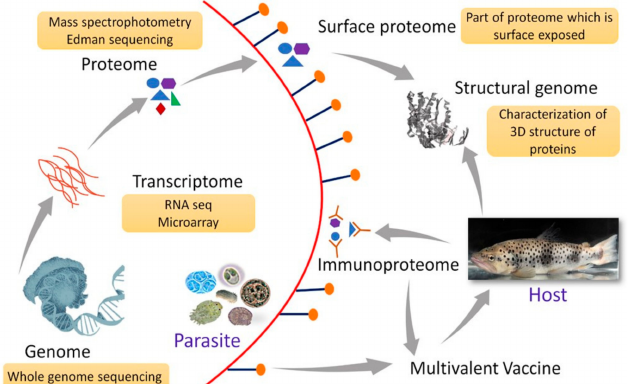
Figure 1. Conceptual representation of multivalent/multiepitope vaccine formulation for fish para- sites in the omics era. Analysis of genomic, transcriptomic and proteomic data of parasite and the data obtained from host–parasite interactions enable identifying a suitable antigen as vaccine candidates. Genome sequence contains the entire genetic repertoire of antigens from which novel vaccine targets can be selected. Transcriptome analysis provides insights on the parasite gene expression profile leading to successful establishment and pathology in host. Proteomic analysis provides information on protein expression under specified conditions. It is useful in identification of proteins that are ex- pressed by parasite during infection and the subset of proteins which are present on parasite surface (surface proteome). Surface exposed proteins which are immunogenic in the host can be suitable vaccine candidate. Structural genomics helps to know the three-dimensional structure of proteins produced by an organism and how they interact with antibodies or drugs. Immunoproteomics provides information on the proteins or epitopes which interact with host antibodies.